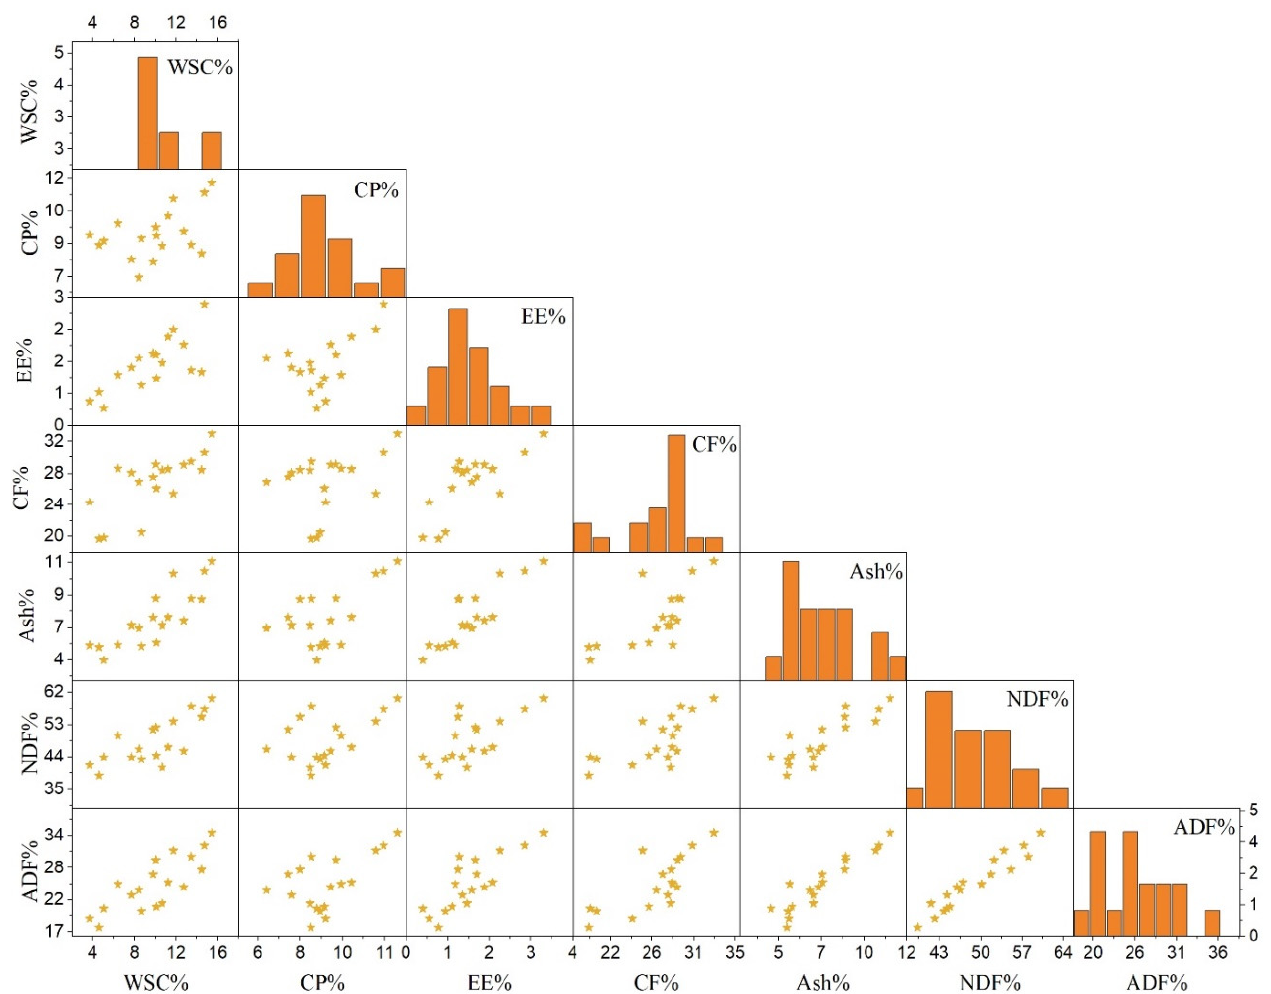
Figure 2. Scattered plot matrix analyses between water-soluble carbohydrates (WSC), crude protein (CP), ether extract (EE), crude fiber (CF), ash, neutral detergent fiber (NDF), and acid detergent fiber (ADF) of forage conducted by cereal mono-cropping and cereal–legume mixed cropping. Diagonal boxes showed histograms for each variable. The lower triangular matrix shows the relationship between a pair of variables.